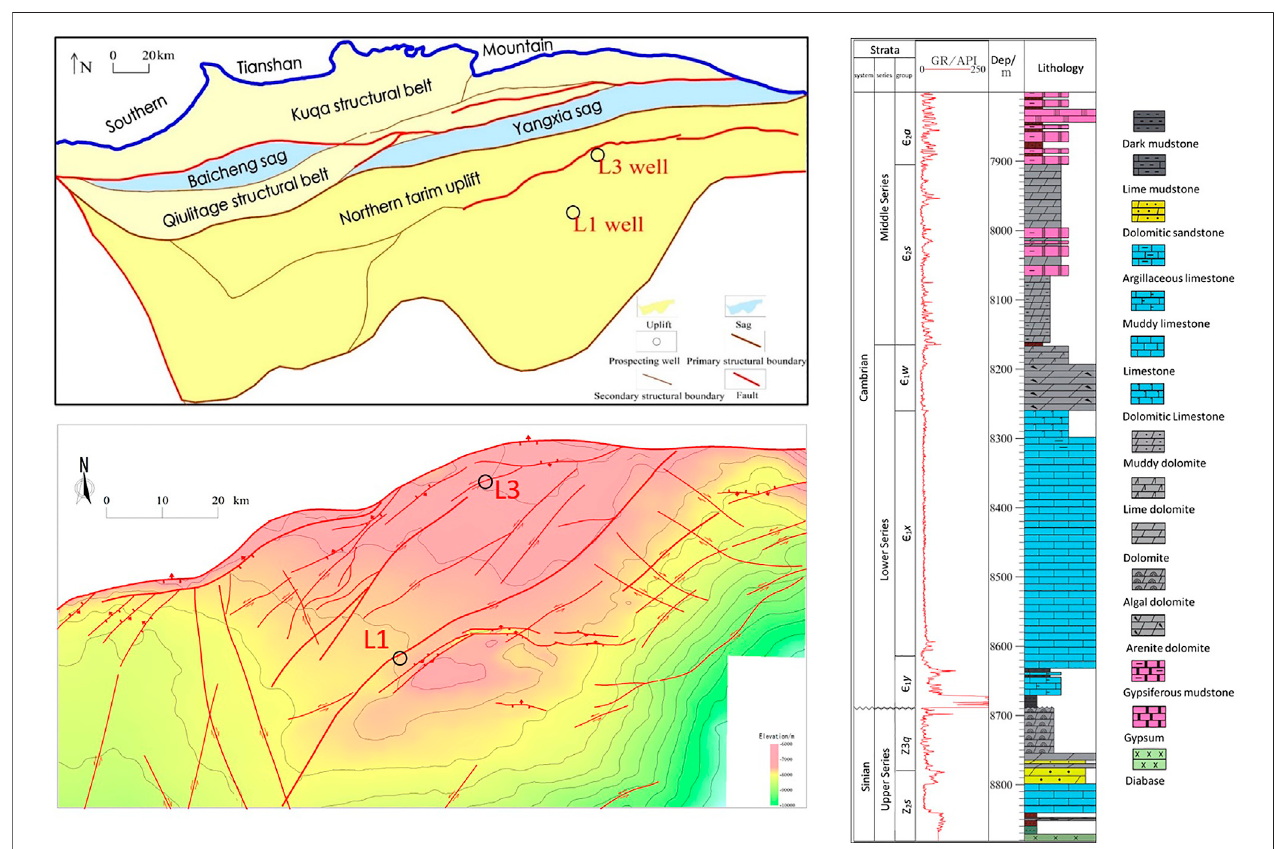
FIGURE 1 | Tectonic location and